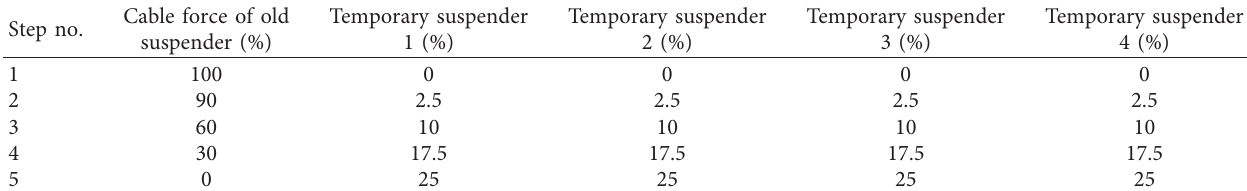
Table 5: Conversion relationship between old suspender cable force and temporary suspender during unloading. Cable force of old Step no.